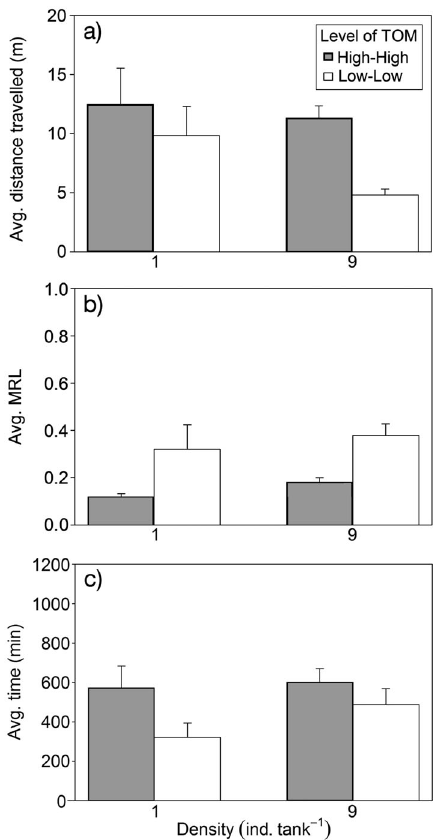
Fig. 3. (a) Average distance travelled by California sea cu- cumbers Parastichopus californicus , (b) average mean re- sultant length (MRL; see ‘Statistical analyses; Materials and methods’ for details) and (c) average time spent moving along the bottom of the tank in response to level of total organic matter (TOM) and sea cucumber density (ind. tank −1 ). Results are for foraging experiments with a single level of TOM within a tank. Values are mean ± SE (n = 7). TOM levels: high, ~8%; medium, ~4.4.%; low, ~1.4%